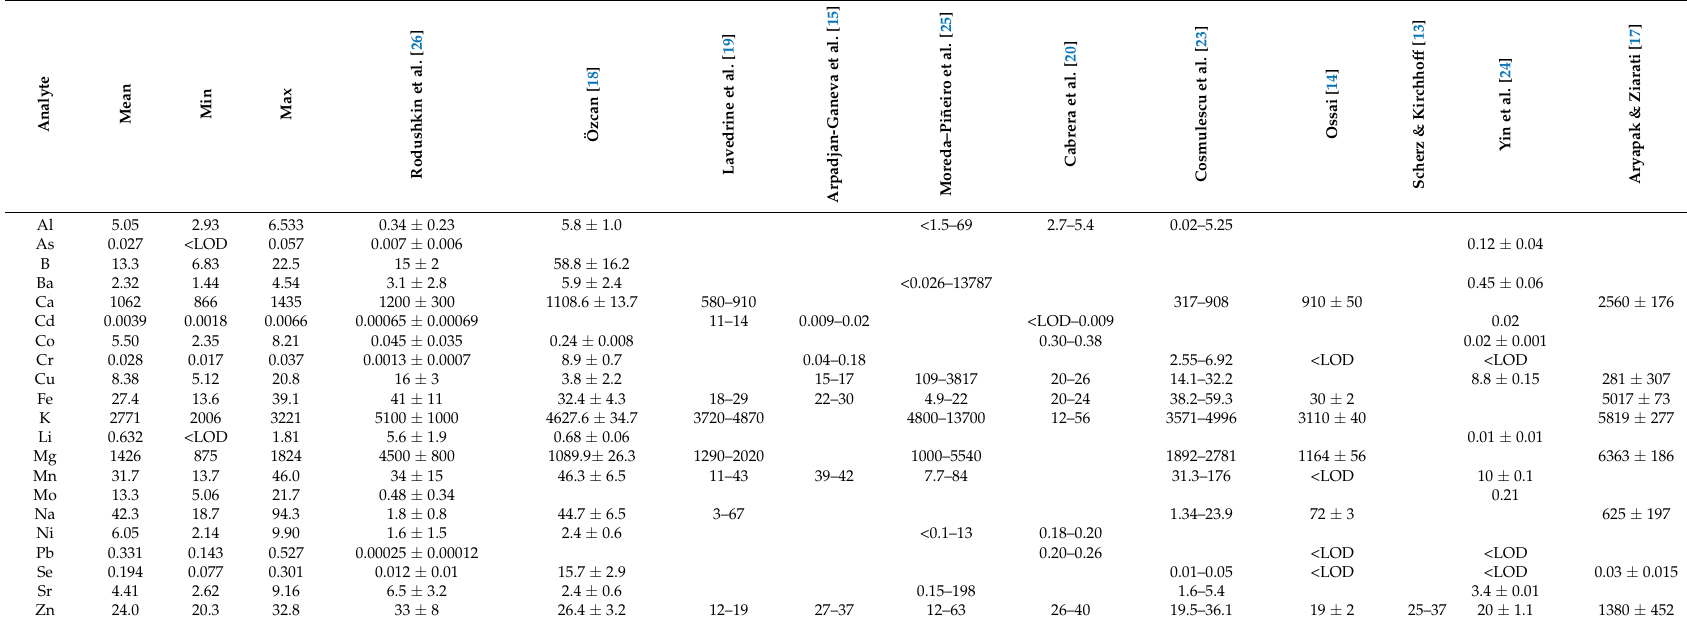
Table 1. The content of elements in walnuts as compared to literature values